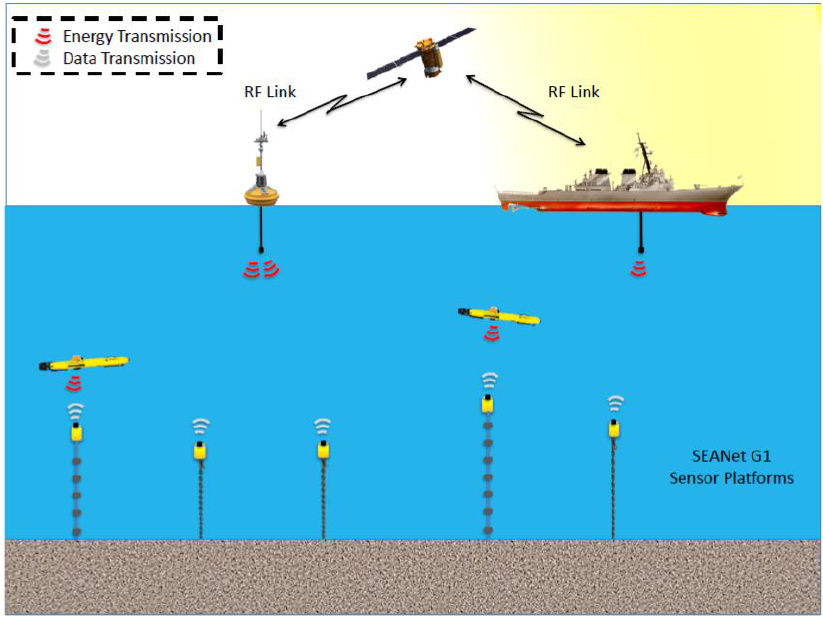
Figure 11. A battery-less IoUT system [77].